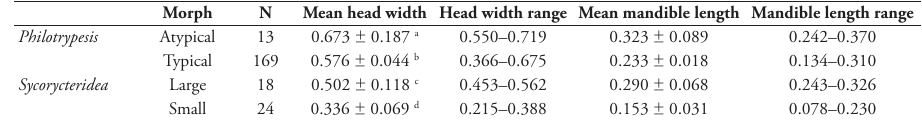
Means are given ± SE. Numbers with different letters indicate significant